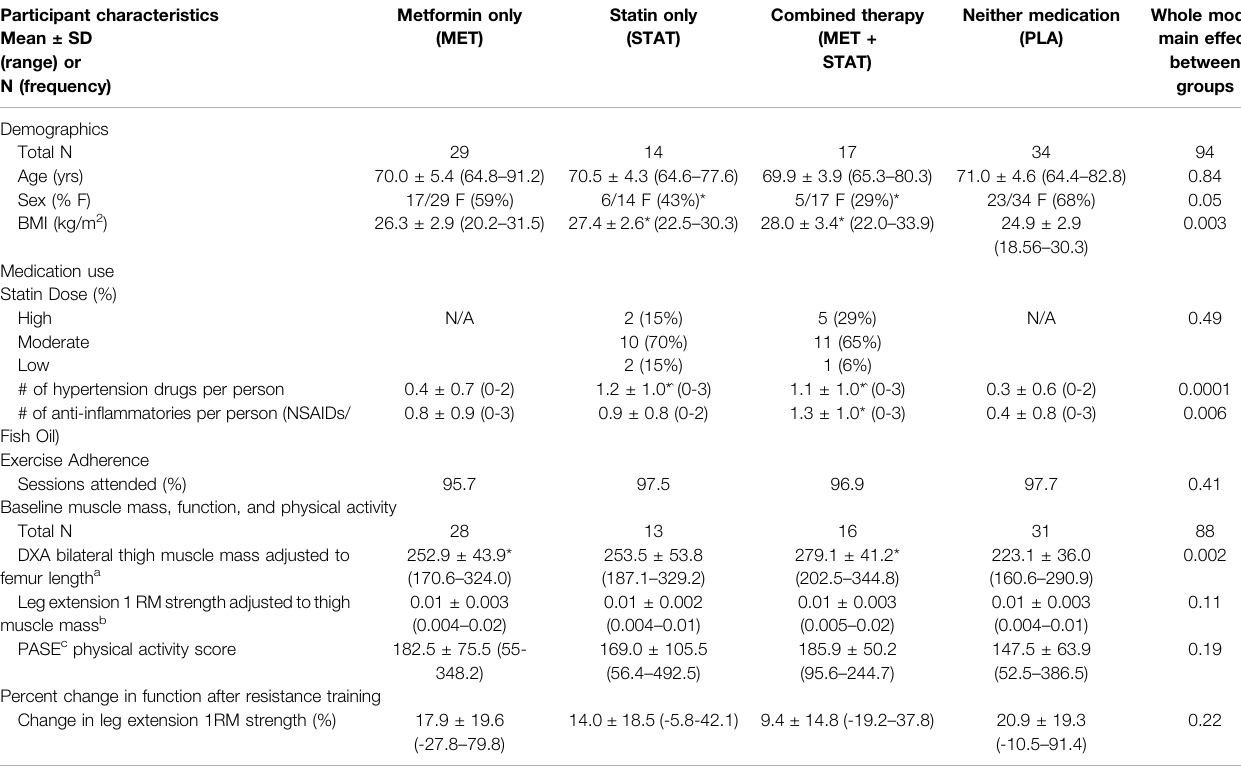
TABLE 1 | Baseline participant characteristics between medication